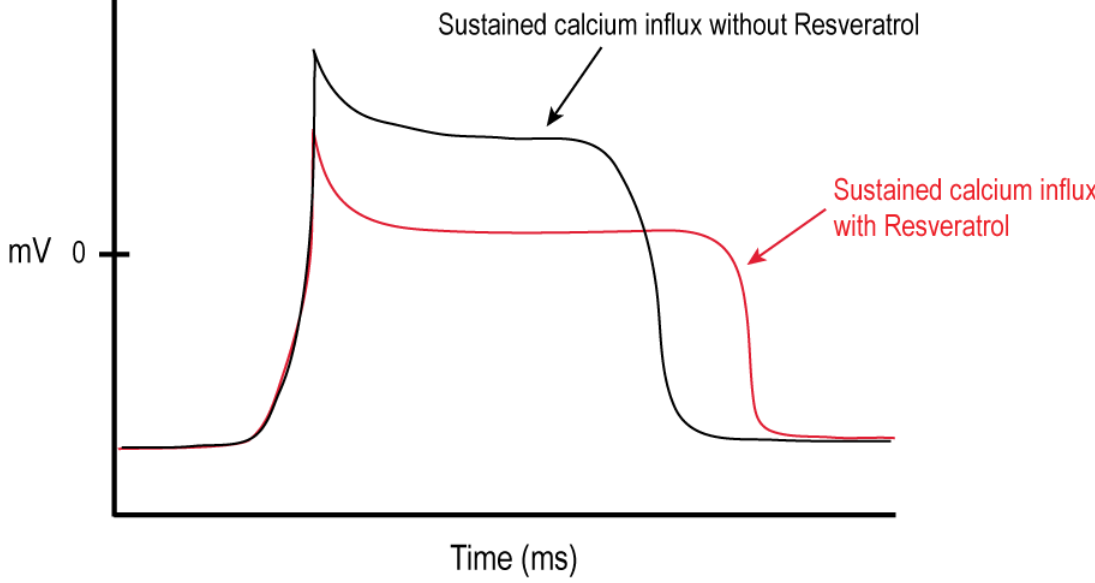
Figure 1. Resveratrol’s mechanism of action in excitable cells . Resveratrol lowers